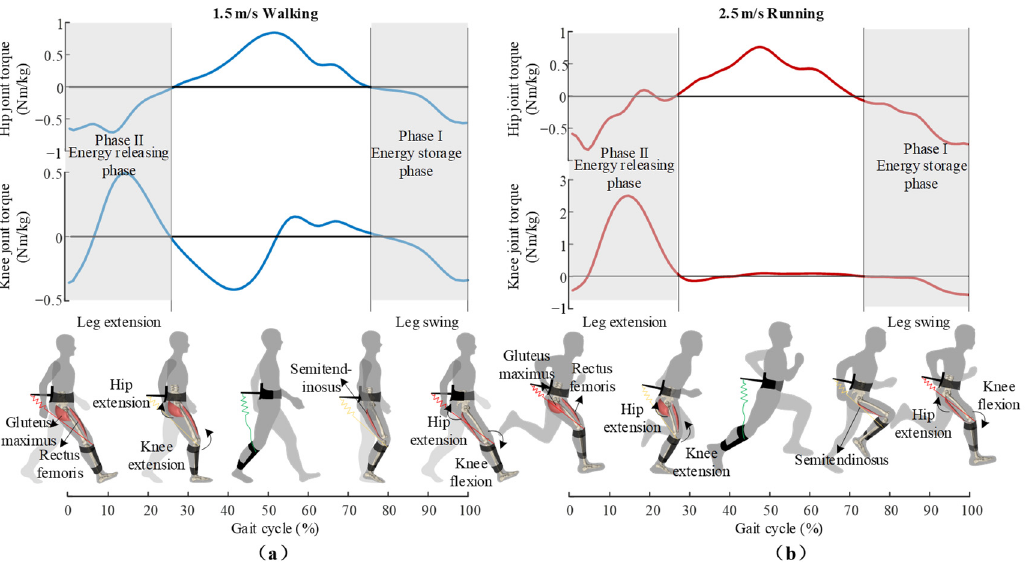
Figure 2. Working process of the exoskeleton during ( a ) walking and ( b ) running. The exo-tendon firstly emulates the double-actuation of hamstrings to store part of the kinetic energy during leg swing while providing hip with extension torque. As the force arm lever changes with hip and knee joint angles, the exo-tendon provides hip and knee joint with hip extension and knee extension torques during energy releasing phase. In this phase, the exo-tendon releases the stored energy to assist co-contraction of gluteus maximus and rectus femoris, and thus realize the phased modulation of hip–knee biomechanical energy.